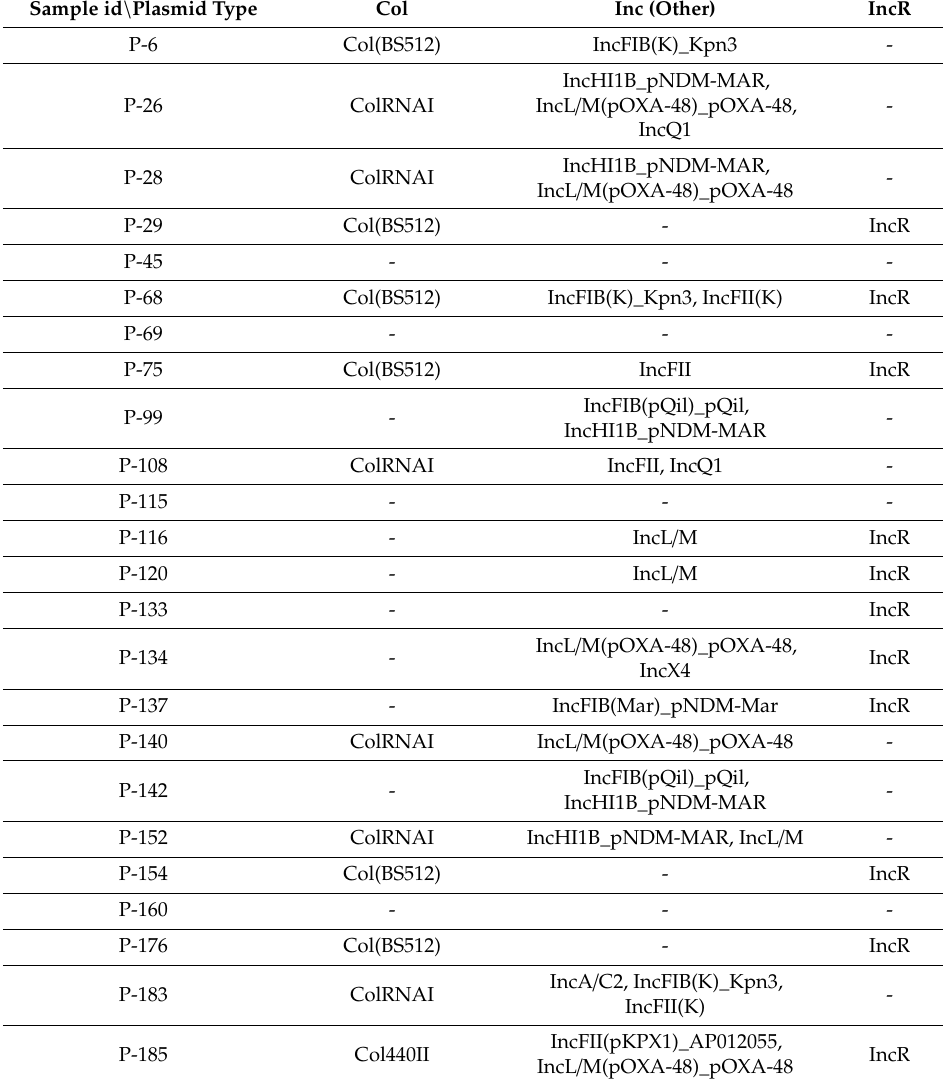
Table 3. Plasmid sequences found in the